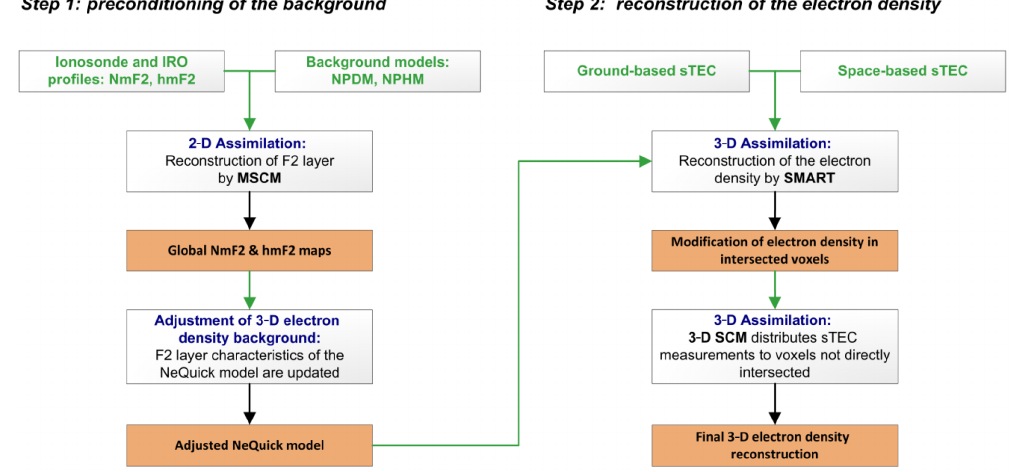
Figure 4. Reconstruction scheme.